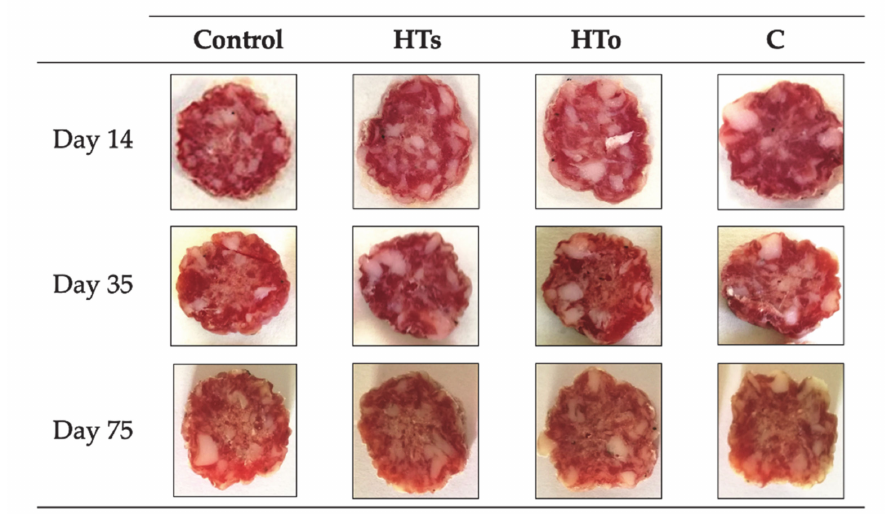
Figure 2. Photographs of reformulated fuet samples. HT s , samples enriched with synthetic Hydroxy- tyrosol; HT o , samples enriched with organic Hydroxytyrosol; C, samples enriched with citric.